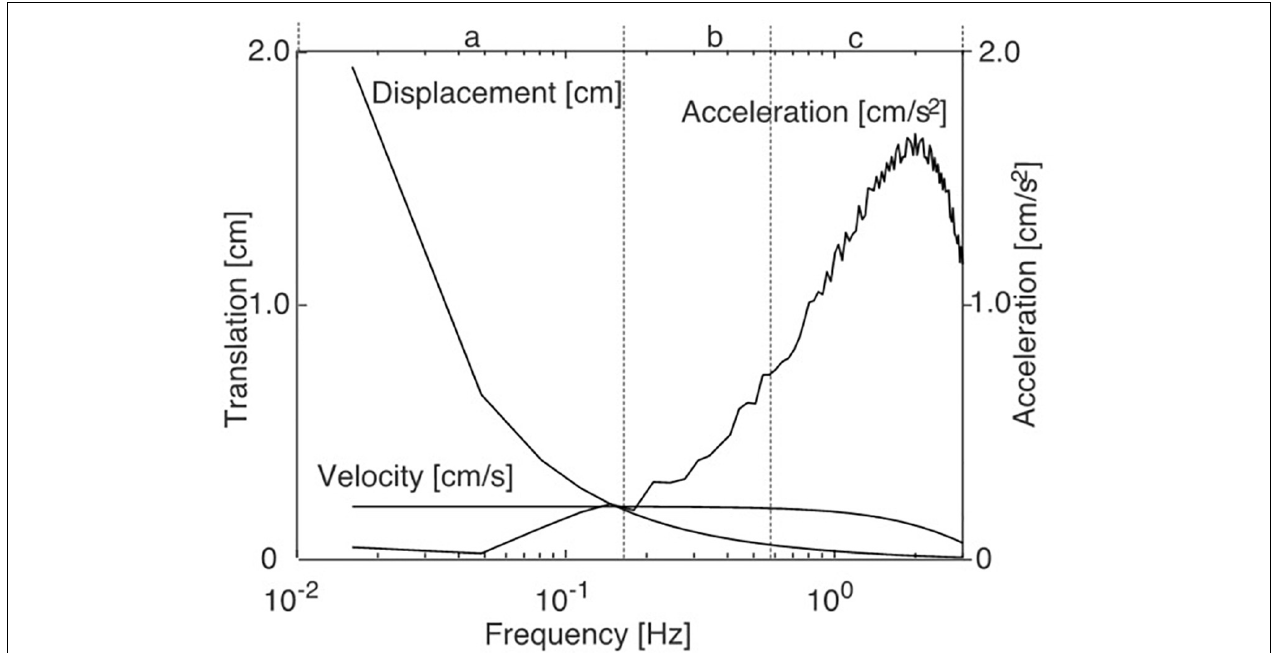
FIGURE 2 | Spectral characteristics of the PRTS (pseudo-random ternary sequence) translation stimulus. a, b, and c give the low, mid, and high frequency (and acceleration) ranges referred to in the text and the Results